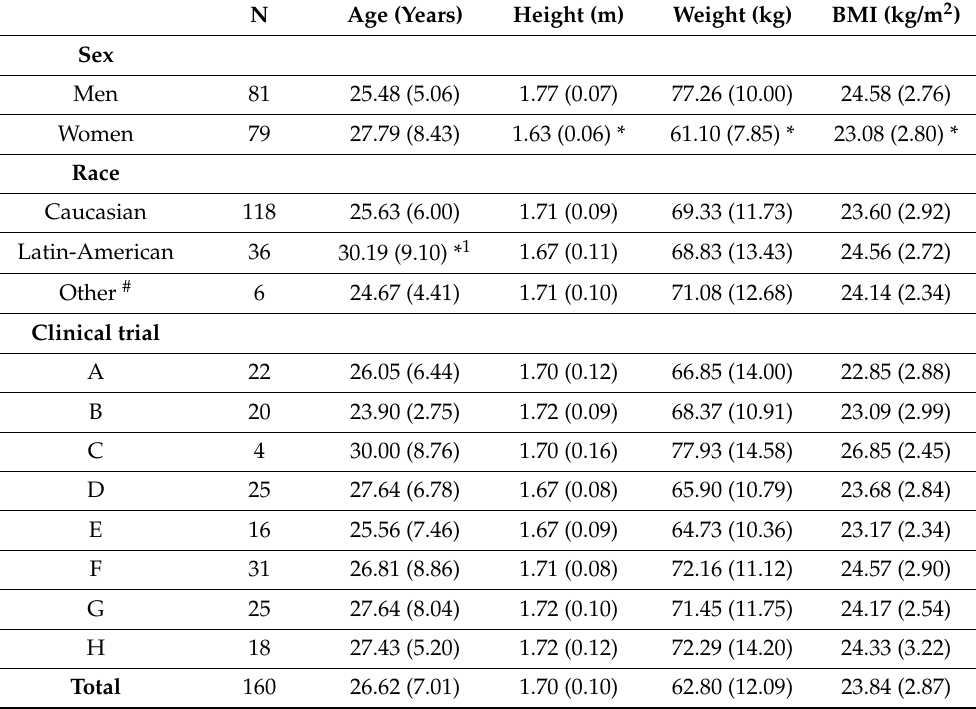
Table 2. Demographic characteristics regarding sex, race and clinical trial.